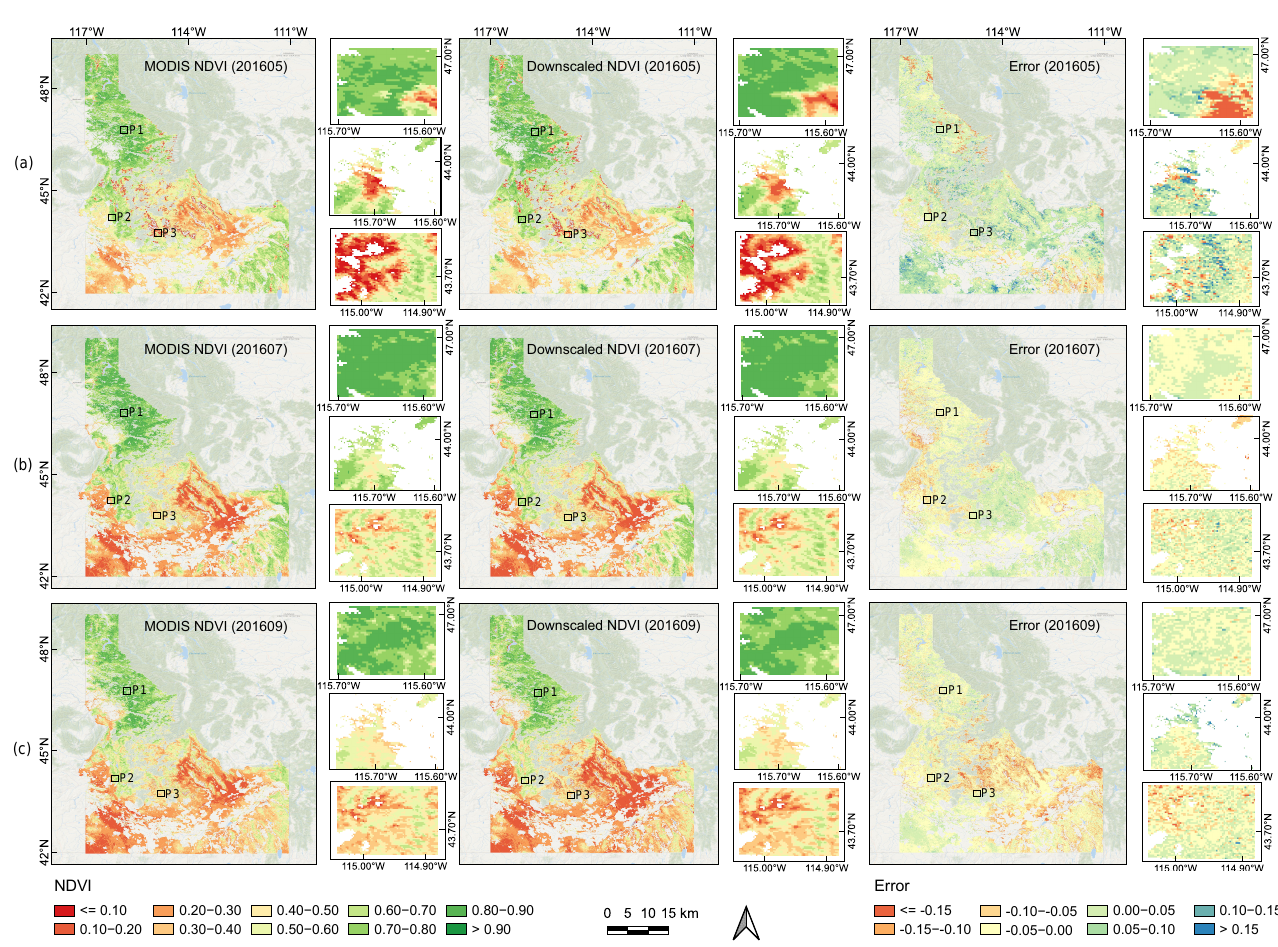
Figure 3. Comparisons of NDVI between the downscaled and MODIS datasets and the difference maps for the Idaho state and at three selected vegetation patch areas in May ( a ), July ( b ), and September ( c ) in 2016. P1–P3 refer to three representative portions of around 30 km 2 in the vegetation- rich area. P1 and P2 are mainly dominated by evergreen needle leaves, and P3 is mainly covered by